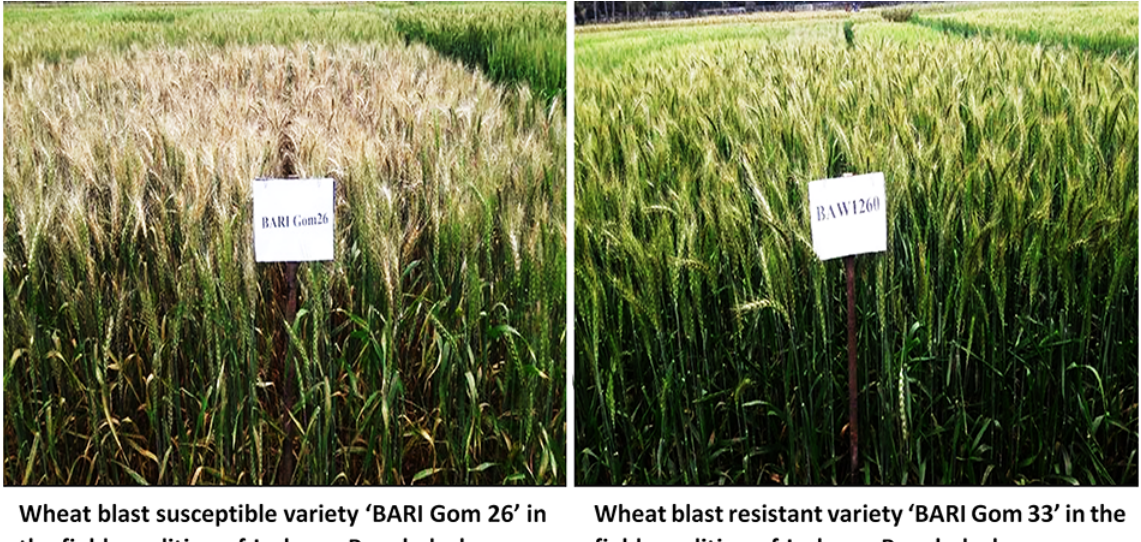
Fig. 5 Variety ‘BARI Gom 33’ showing resistance against wheat blast in the field conditions of Jashore – Bangladesh. Adapted from